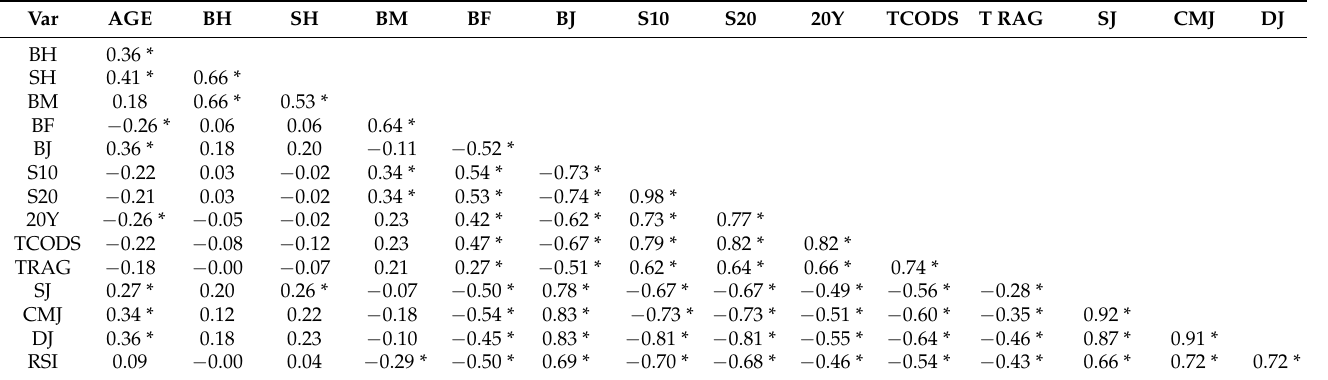
Table 1. Pearson’s moment correlation coefficients between the studied variables for boys.